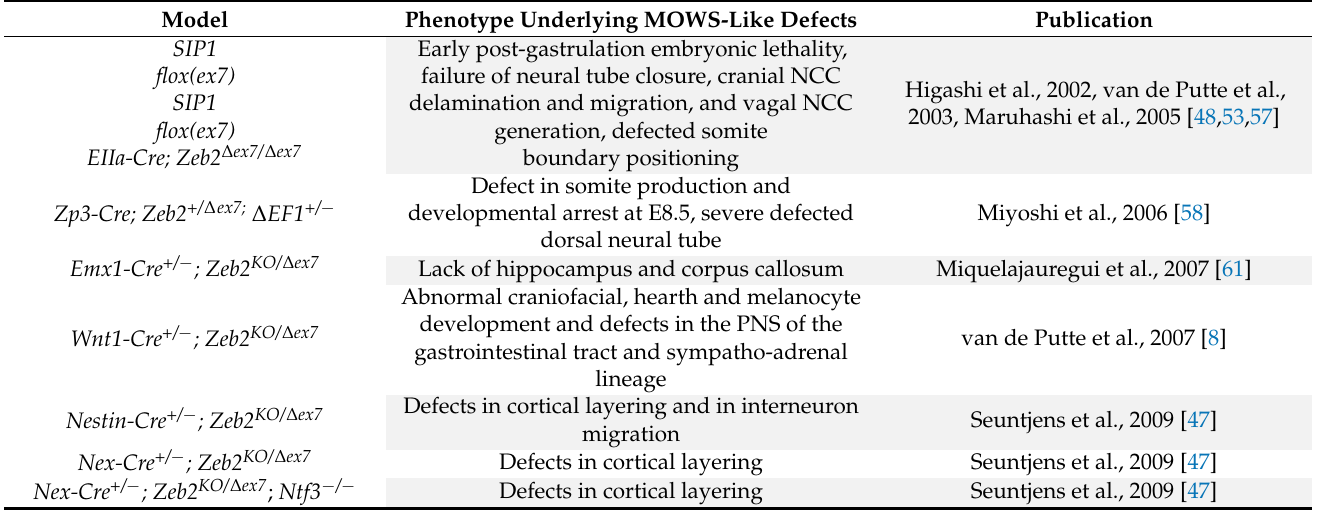
Table 1. Mouse models associated with MOWS-like phenotypes (with ∆ = the result of Cre action).